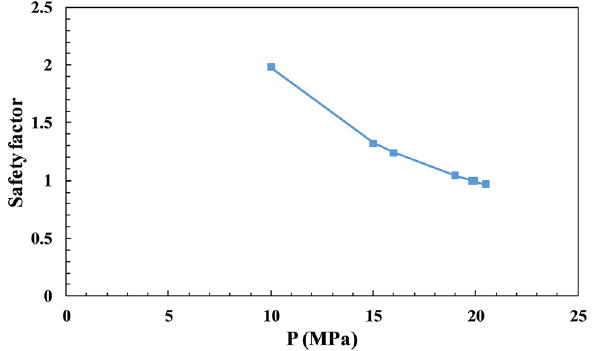
Fig. 6 The von Mises stress in the burst pressure of the pipe repaired by a isotropic sleeve and b orthotropic sleeve